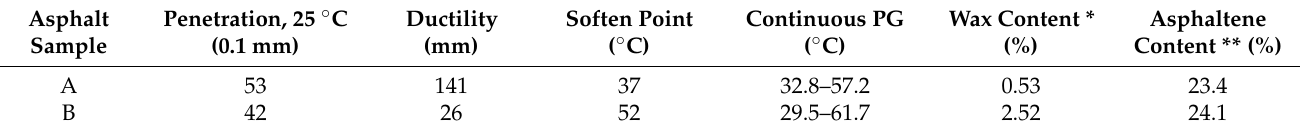
Table 1. Main technical indexes of asphalt A and B.